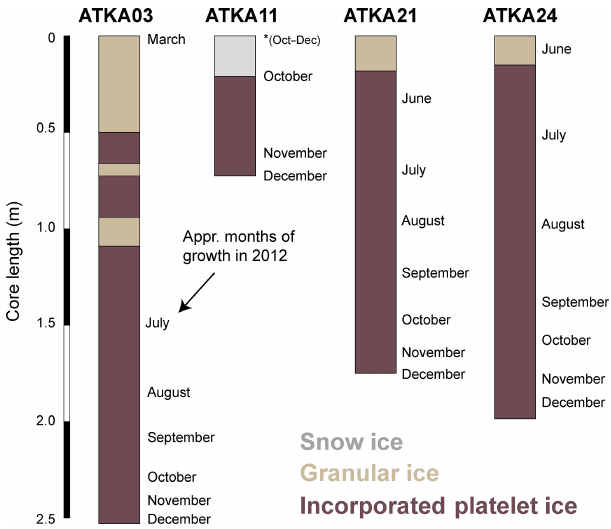
Figure 9. Sea-ice crystal fabric from ice cores obtained at four dif- ferent fast-ice sampling sites in December 2012, derived from ver- tical and horizontal thin sections (0.1m spacing) along the full core length (see also Hoppmann et al., 2015a, b; Hoppmann,